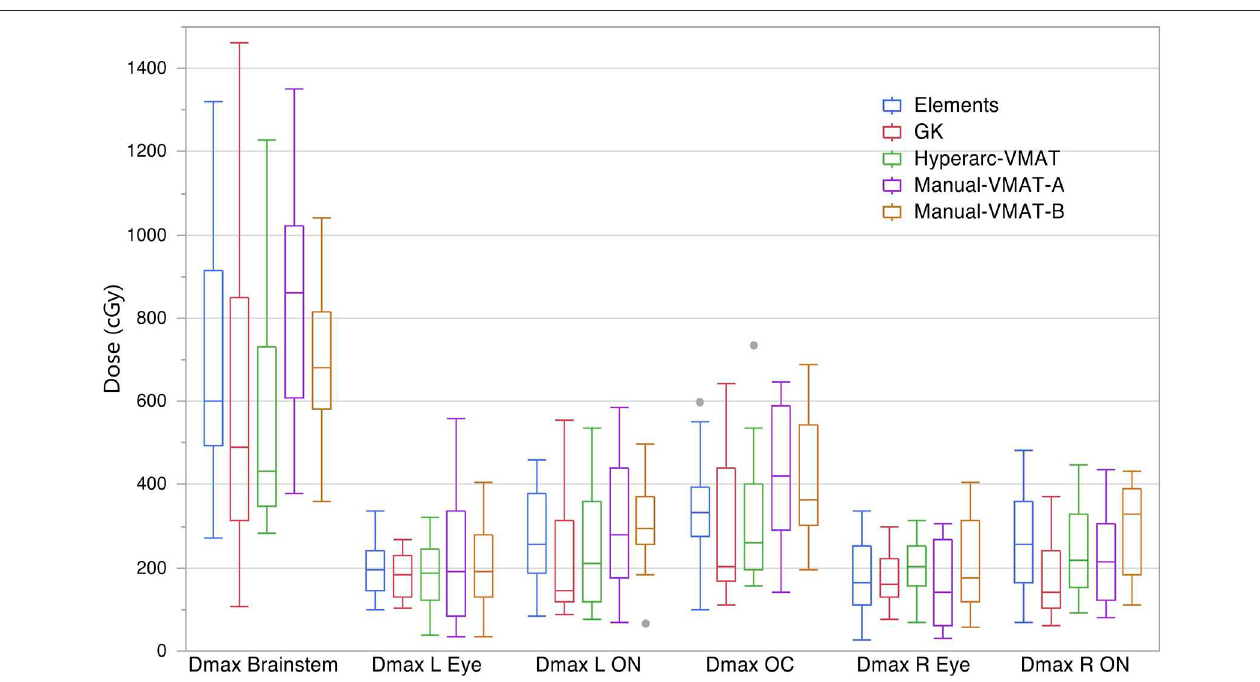
FIGURE 4 | Box plot results per SRS plan type for the following dosimetric parameters across all patients: the maximum dose to the brainstem (D max Brainstem), maximum dose to the left eye and optic nerve (D max L Eye and D max L ON), maximum dose to the right eye and optic nerve (D max R Eye and D max R ON), and maximum dose to the optic chiasm (D max OC).